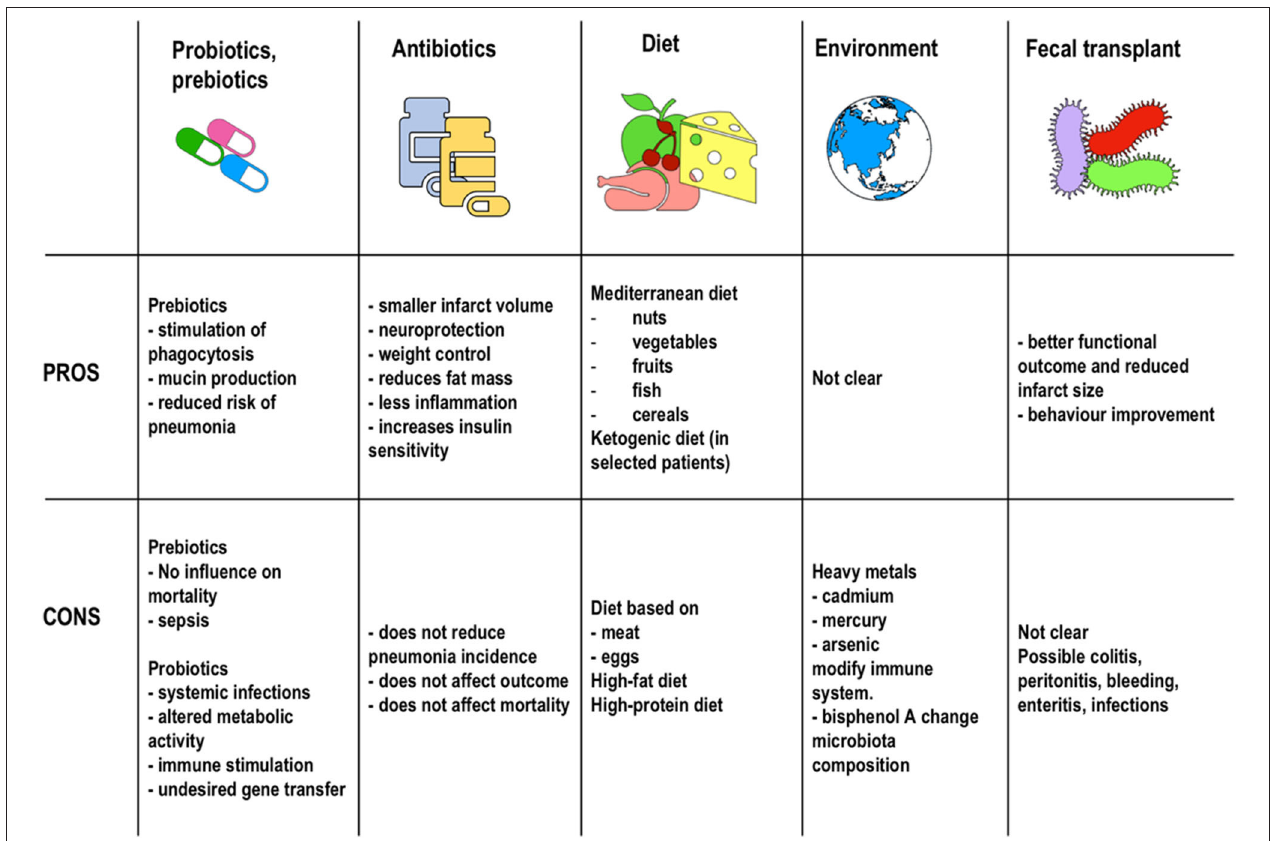
FIGURE 4 | Therapeutic strategies. Pros and cons of the therapeutic strategies described in the literature to date for microbiota manipulation in stroke